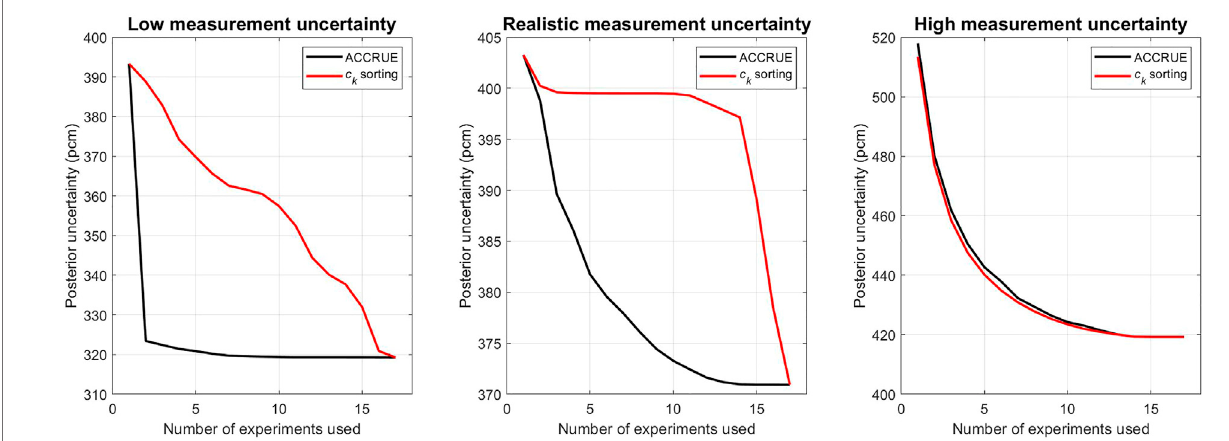
FIGURE 10 | Bias uncertainty reduction for a low relevance application.